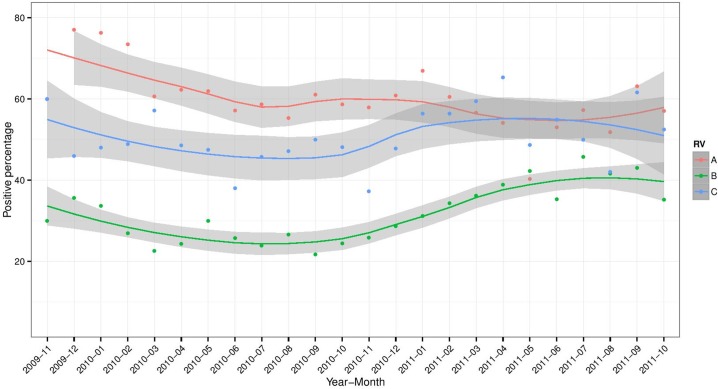
Percentages of positive RVA, RVB, and RVC samples by month.Red, green, and blue dots represent the percentage of positive RVA, RVB, and RVC samples, respectively. Time-series were smoothed by Locally Weighted Regression method, and the gray area represents 95% confidence interval for the fitted line.